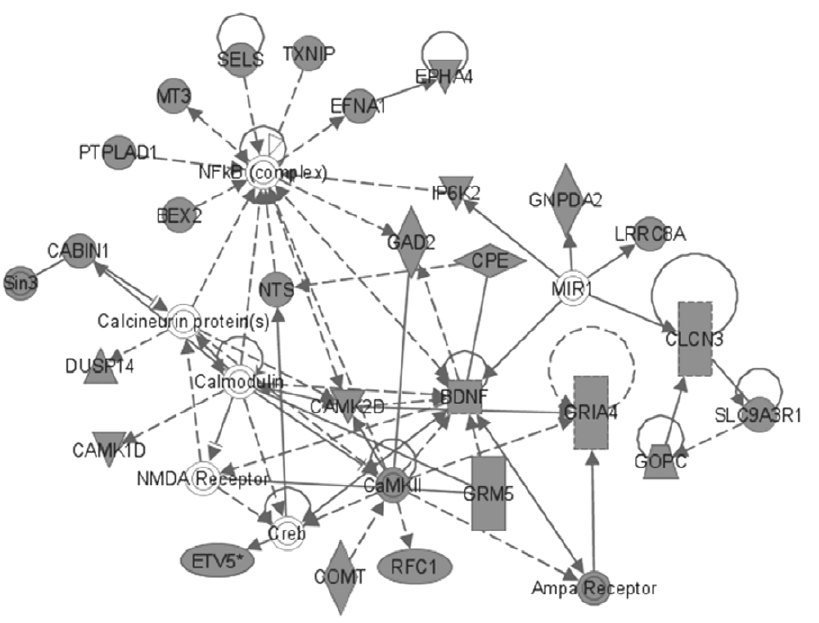
doi:10.1371/journal.pone.0020911.g003